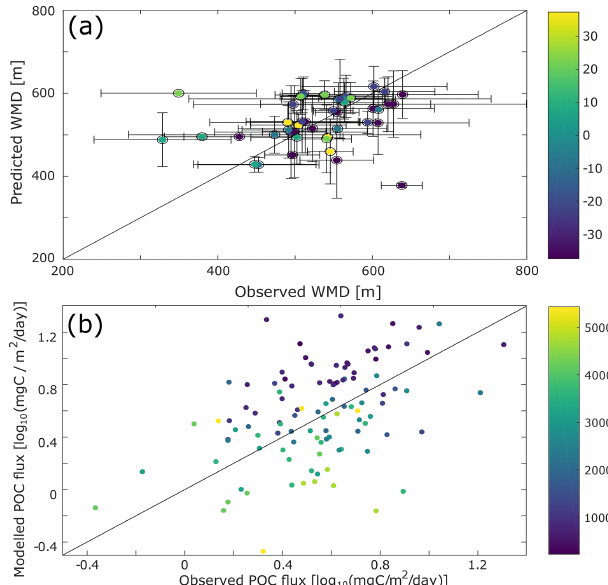
Figure 3. Comparison with data. (a) Scatter plot of the differences between the observed and the model-predicted weighted mean depth (WMD) of the deep scattering layer. (b) Difference between the observed (from sediment traps data; Lutz et al., 2007) and mod- elled particulate organic carbon (POC) flux. To decrease possible biases due to localized blooms, only fixed sediment traps deeper than 500m and with an annual coverage were selected for this com-